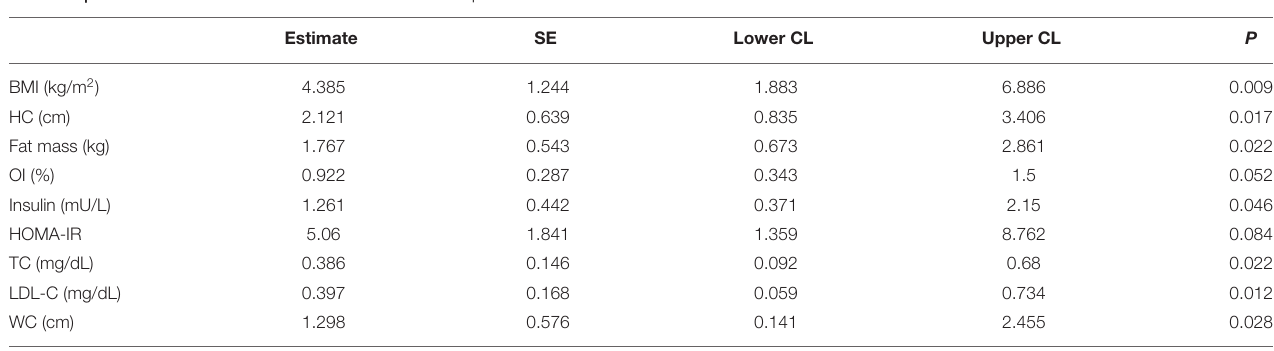
TABLE 8 | Correlation between LV mass and other metabolic parameters.